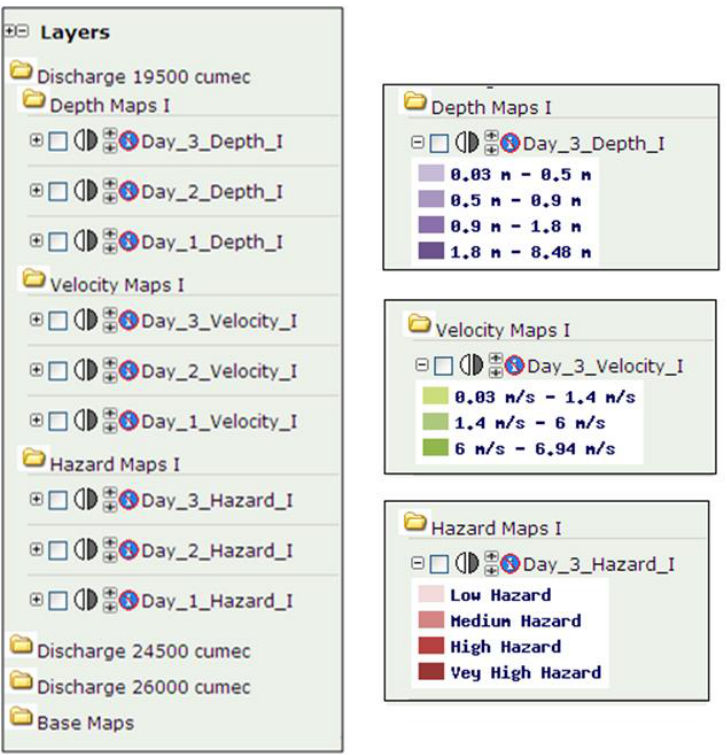
Figure 6. Screenshot of layers available in PROFLIN along with legend for depth map, velocity map, and hazard map. and hazard